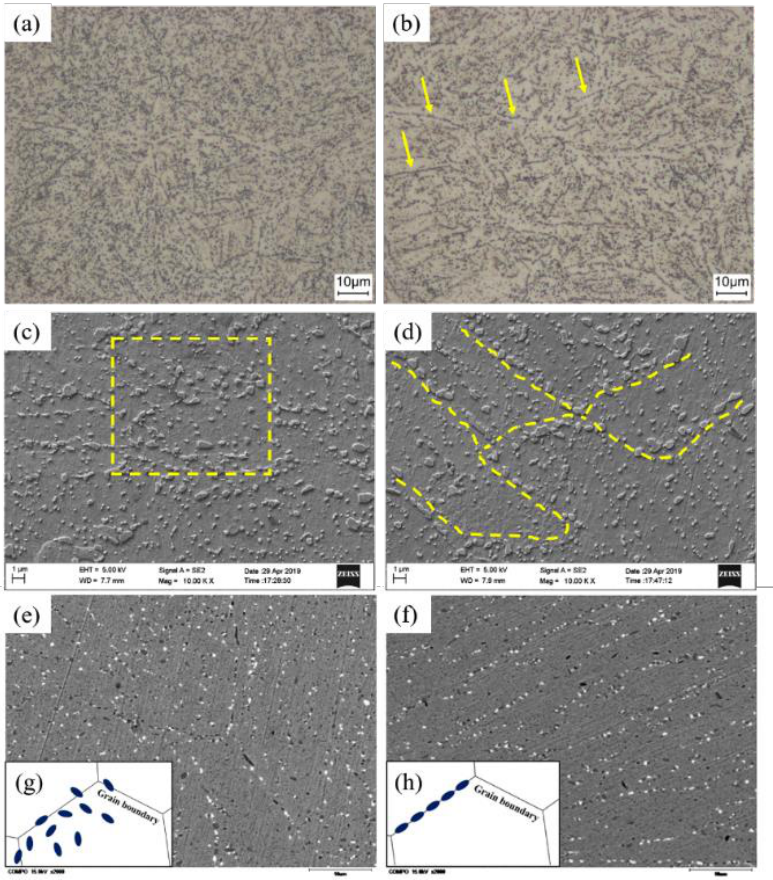
Figure 2. Distribution of carbides after annealing: ( a ), ( c ), and ( e ) H13 die steel; ( b ), ( d ), and ( f ) RE-H13 die steel; Diagram showing the carbide distribution and morphology of the ( g ) H13 die steel and ( h ) RE‐H13 die steel.